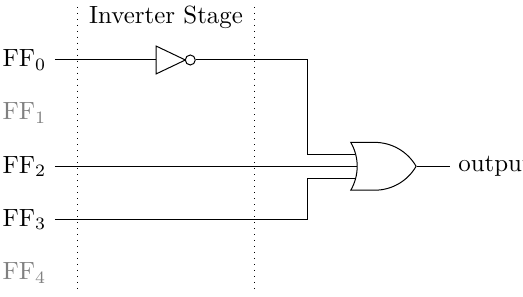
Figure 3: Exemplary interconnection as generated by the RND